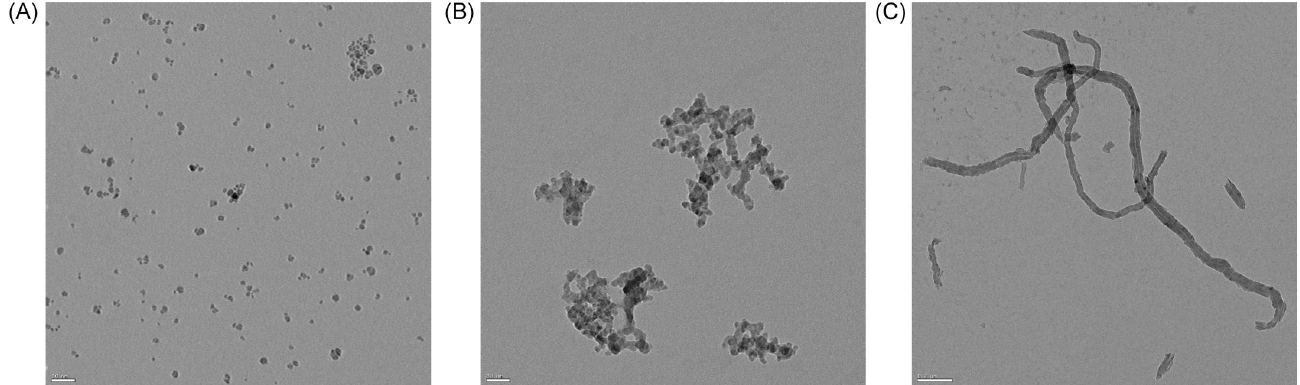
Fig 1. TEM images of NPs suspended in MilliQ water at a 10 μ g/ml concentration. A) SPIONs, B) SiNPs and C) CNTCOOHs. Scale bars: 50 nm for SPIONs and SiNPs and 0.2 μ m for CNTCOOHs.